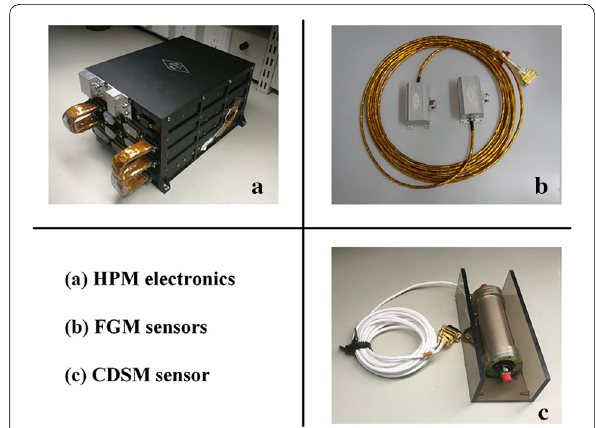
Fig. 1 Pictures of the HPM subunits. a DCU (Digital Control Unit, middle two layers) with the two FGMs (bottom) and CDSM readout electronics on top; b two FGM sensors; c CDSM